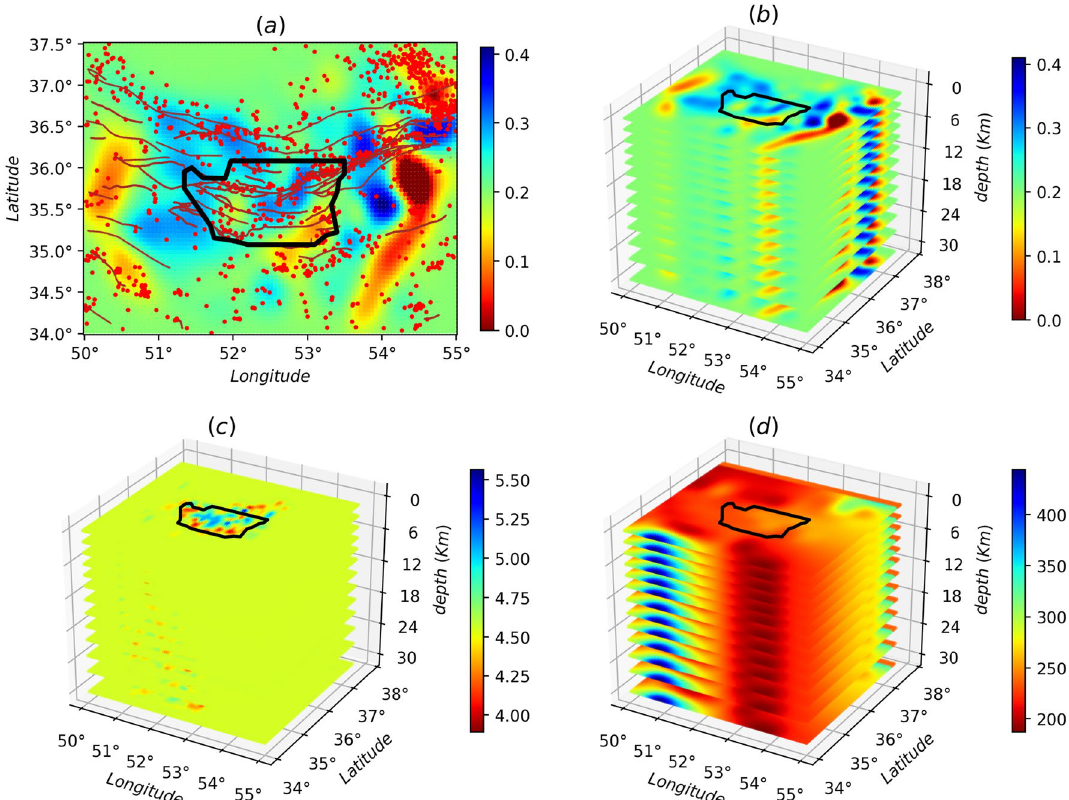
Figure 3. (Color Online) ( a ) A two-dimensional (2D) projection of BTW lattice on the x 1 − x 2 plane ( x 3 = 0 ). The red lines show known faults, and red circles are the events with the magnitude of M ≥ 2.5 . The three- dimensional (3D) projection is shown for ( b ) Cross-Correlation Weight, ( c ) Q-factor 29 , ( d ) P-wave velocity model 36 wherein The Cross-Correlation Weight and Q-factor are robust against x 3